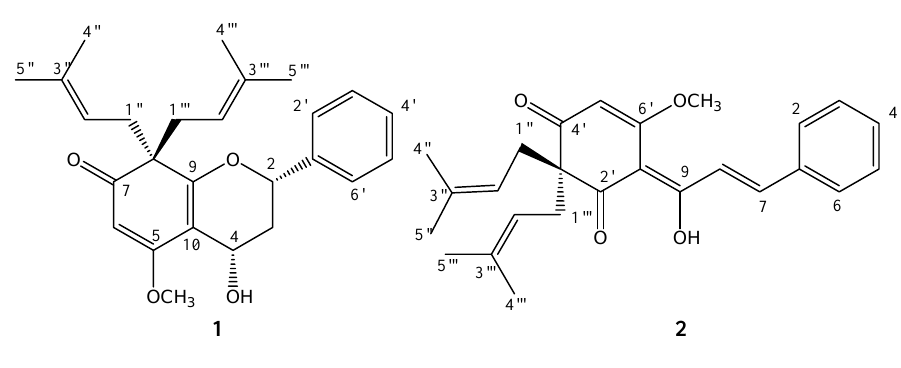
Figure 1. Structures of compounds 1 and 2